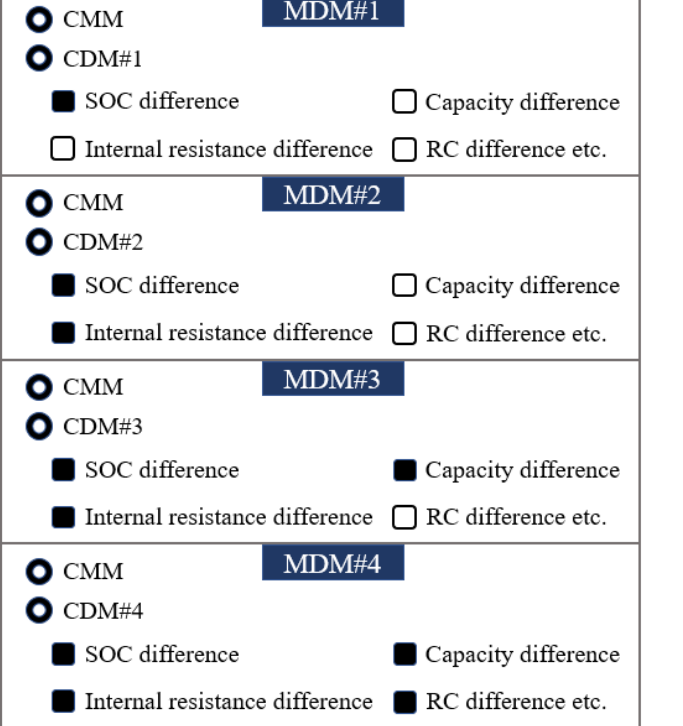
Figure 1. MDMs with different CDMs. Table 1. State equations of MDM#2 model [12].